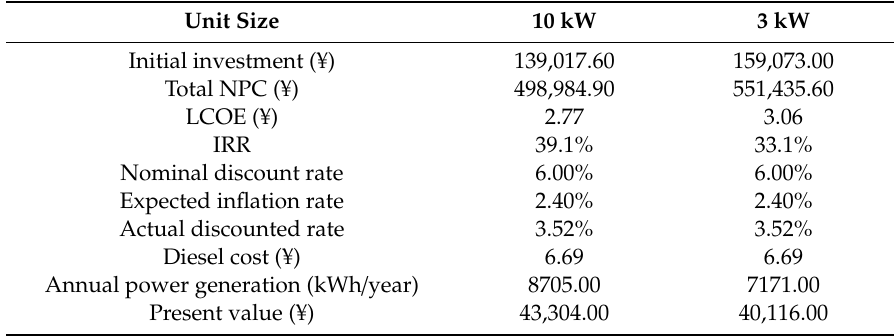
Table 1. WECS data.